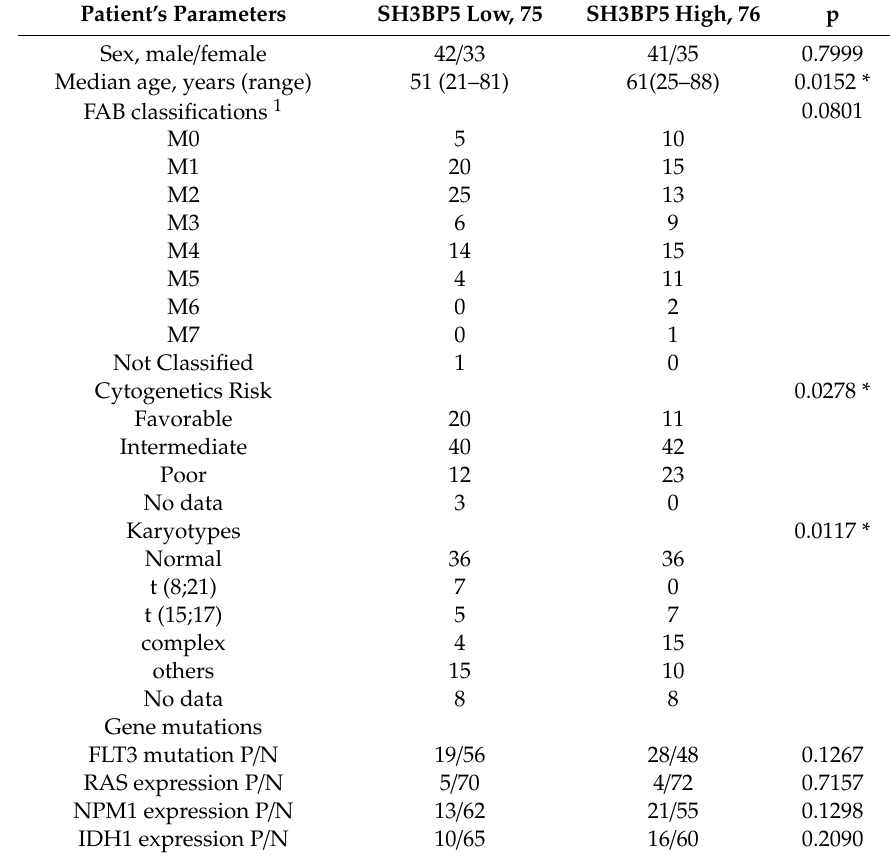
Table 1. Association between SH3BP5 expression and clinicopathological characteristics in AML